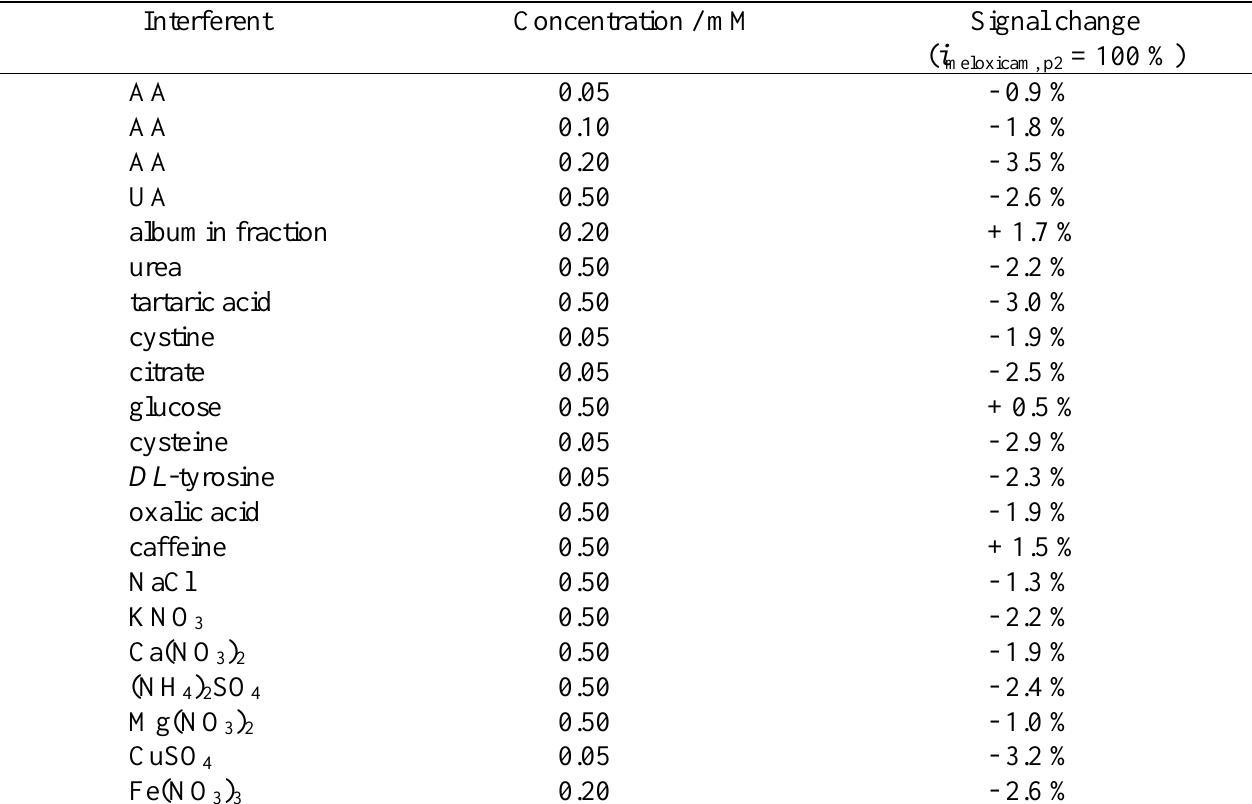
Table 2. Influence of potential interferents on the voltammetric response of 0.50 µM